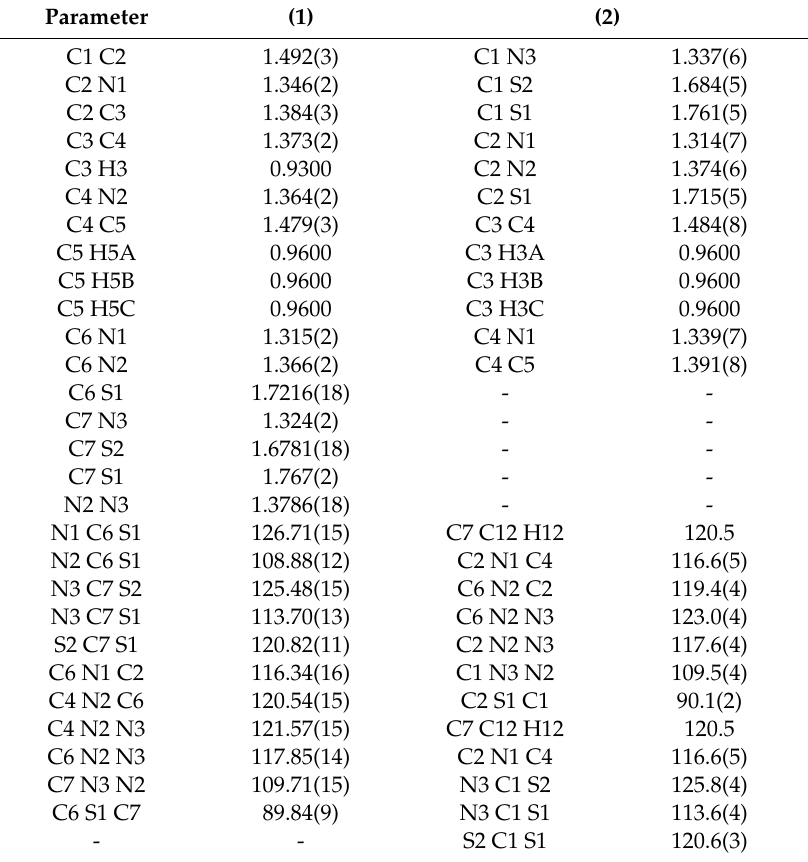
Table 2. Selected bond lengths (Å) and angles ( ◦ ) of 1 and 2